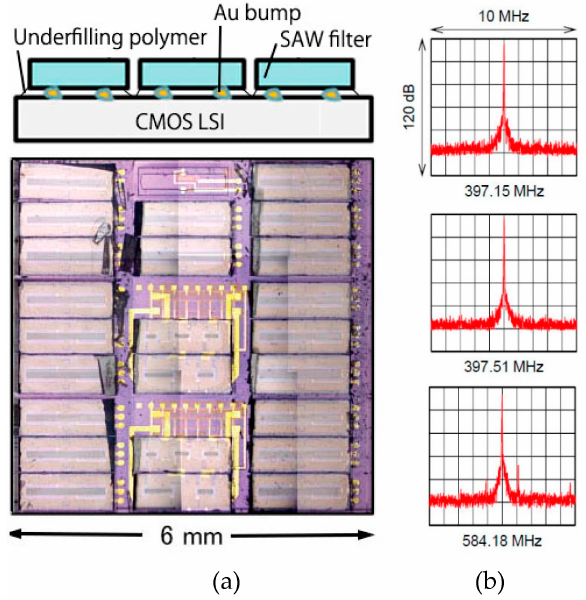
Figure 8. Multi SAW resonators on a LSI chip; ( a ) structure and photograph; and ( b ) frequency spectrums of three SAW oscillators on LSI.